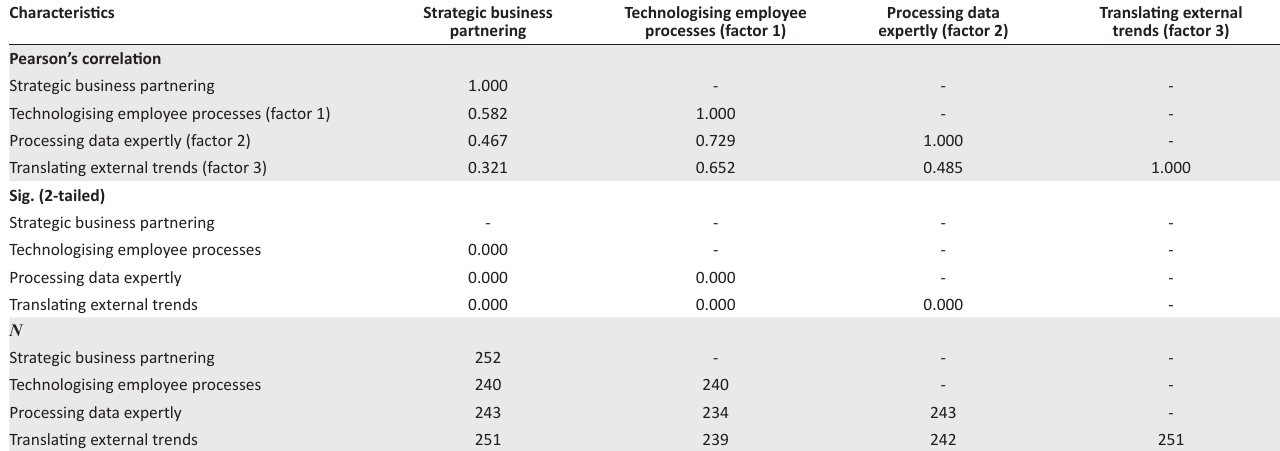
TABLE 3: Correlations between identified factors and strategic business partnering. Characteristics